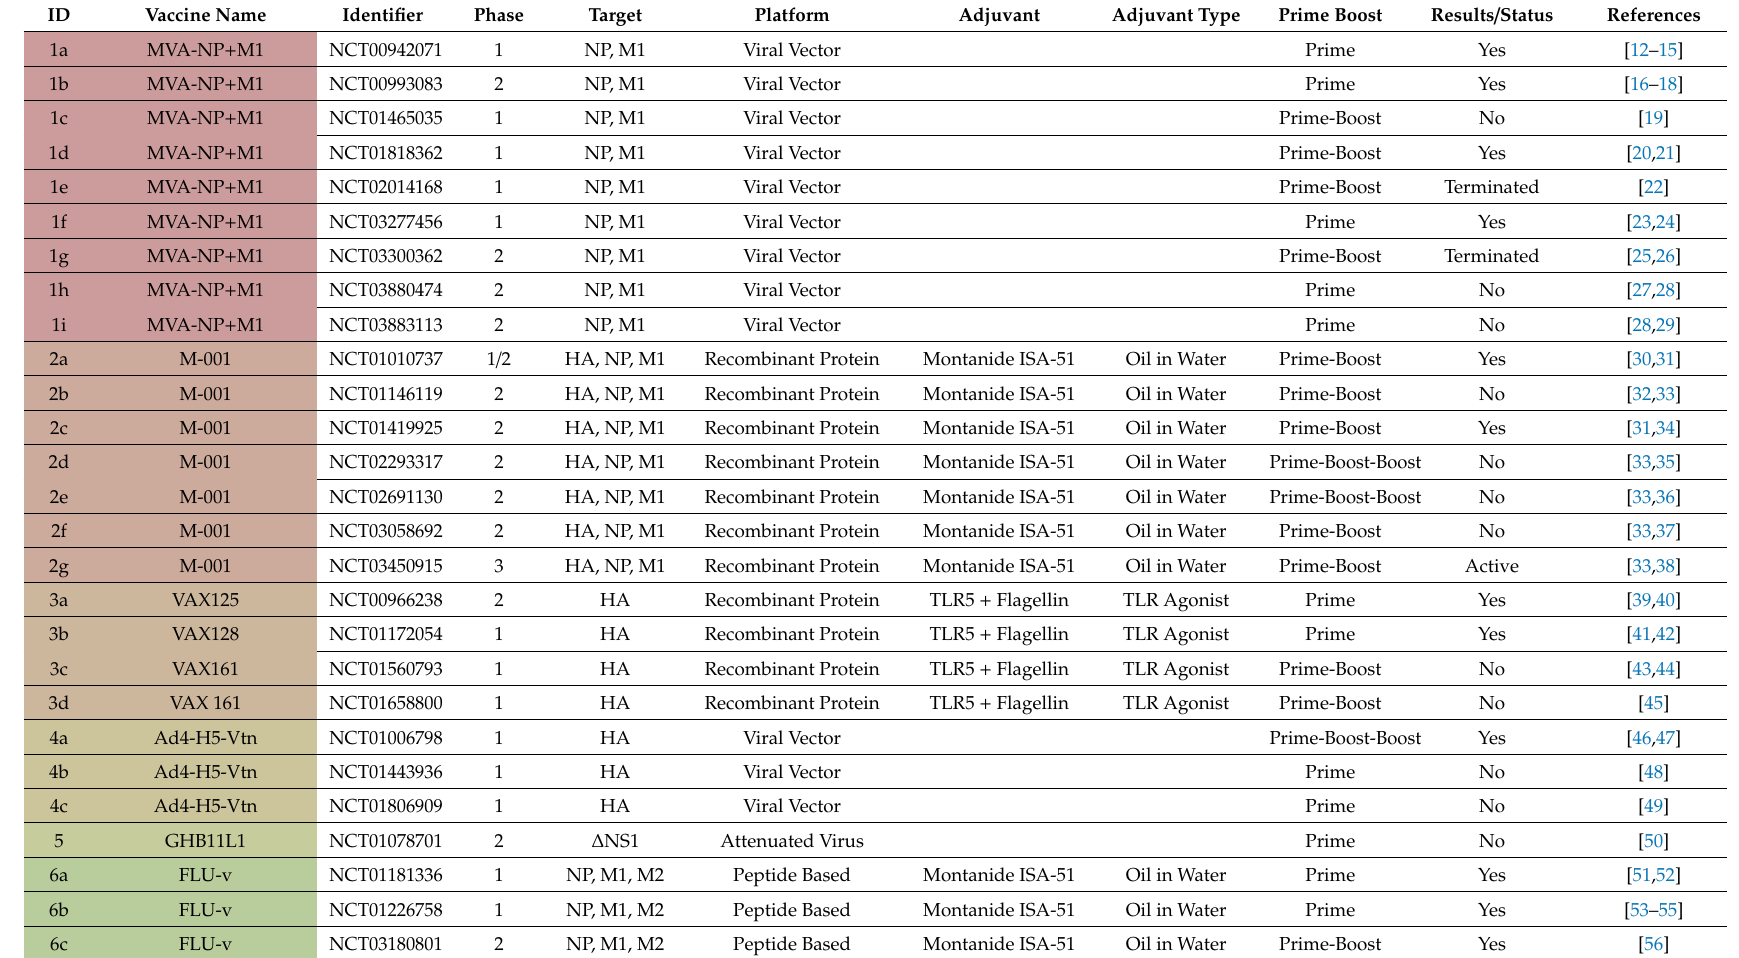
Table 1. Characteristics of universal influenza vaccine clinical